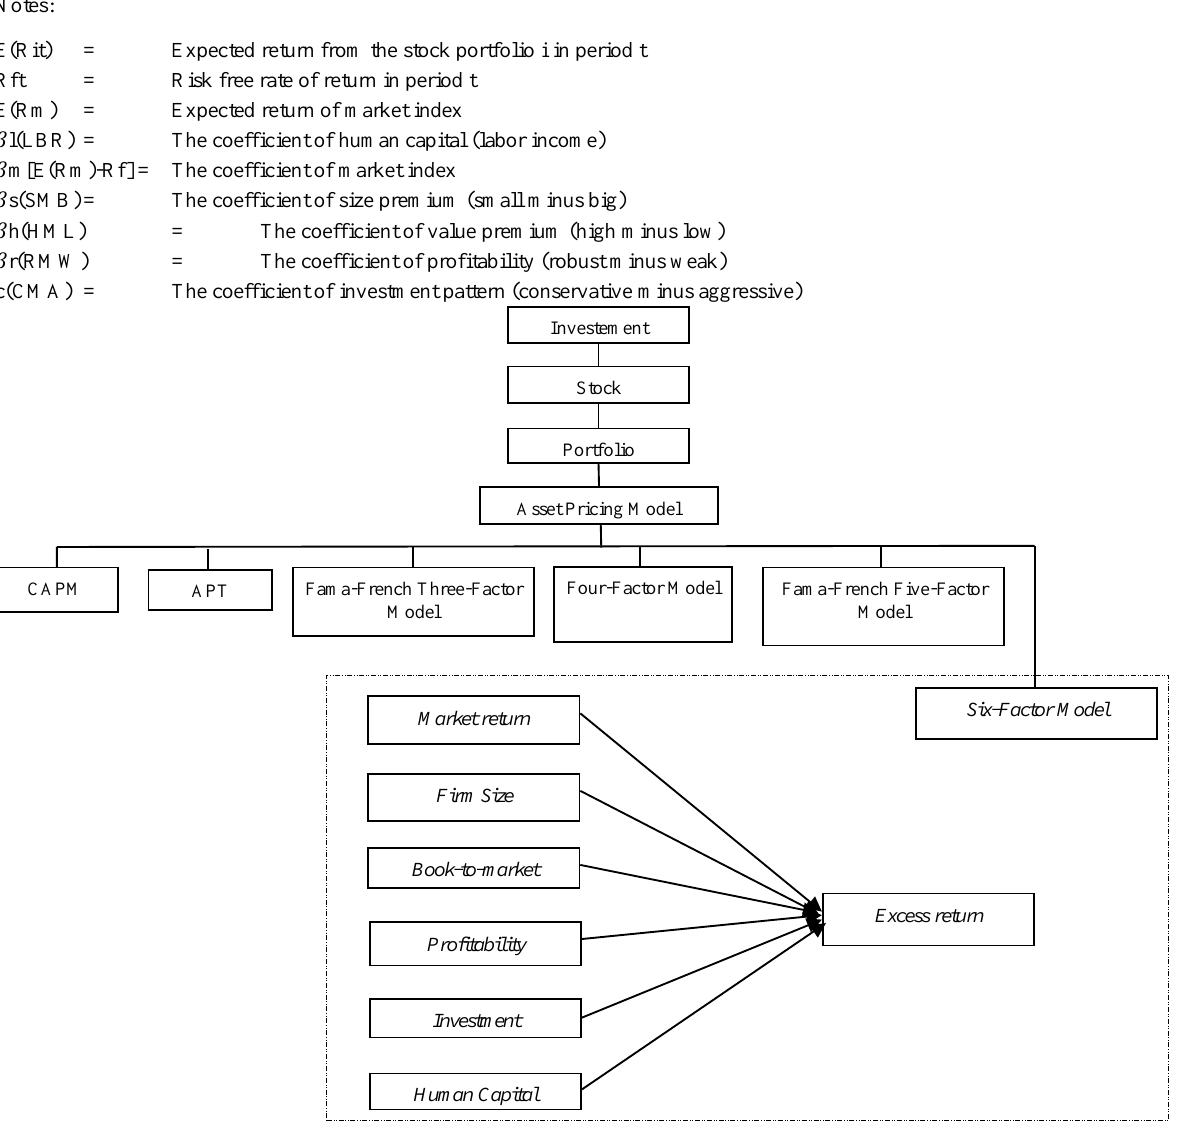
Figure 1: Proposed conceptual